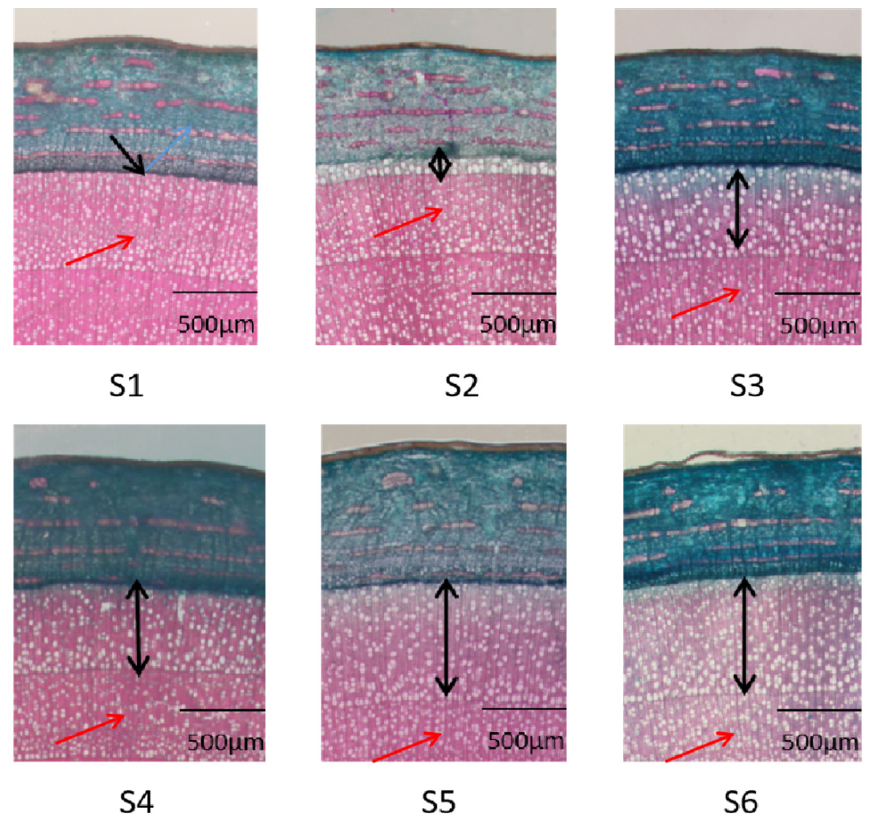
Figure 1. The picture shows the cross-section histological observation of the stem nodes of S1–S6 in six different sampling periods in the “Shanxin” poplar. The xylem is dyed by Safranin O-staining and fast-green. Scale bar = 500 mm. The black arrow indicates the newly grown xylem, and the red arrow indicates the last year xylem.